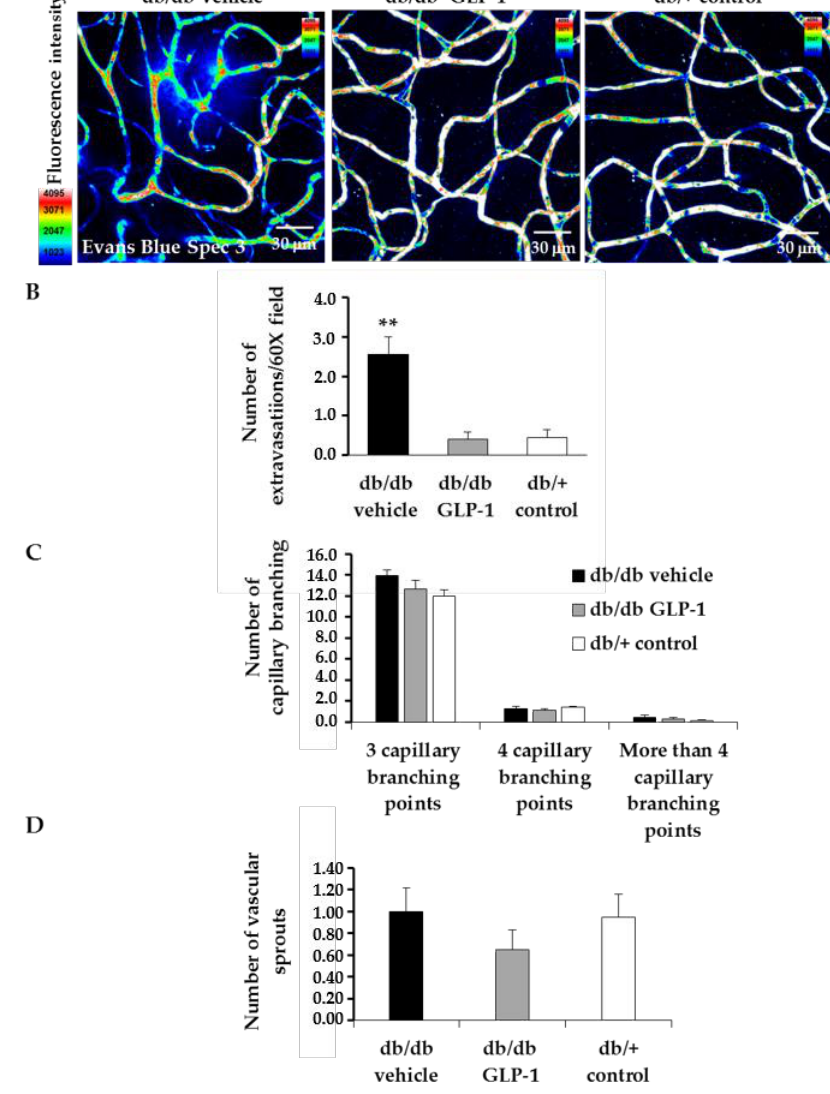
Figure 9. Microvascular abnormalities. ( A ) Confocal immunofluorescence images of vascular permeability assessed by Evans Blue dye leakage in retinal whole mounts. Spec3, fluorescent spectral signature 3. Scale bars, 30 µ m; ( B ) For quantification, the number of extravasations per field of 60 × retina was counted. * p < 0.01 in comparison with the other groups; ( C ) The number of capillary branching and ( D ) The number of vascular sprouts in db/db mice treated with vehicle (black bars), db/db mice treated with glucagon-like peptide-1 (GLP-1) eye drops (grey bars) and non-diabetic mice (white bars). n = 4 per group, 25–30 fields per animal were